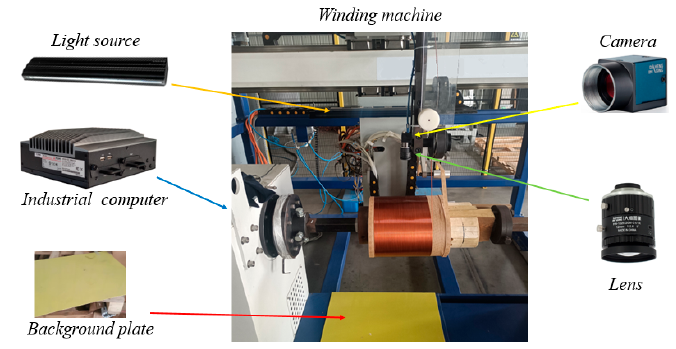
Figure 2. Image acquisition system.